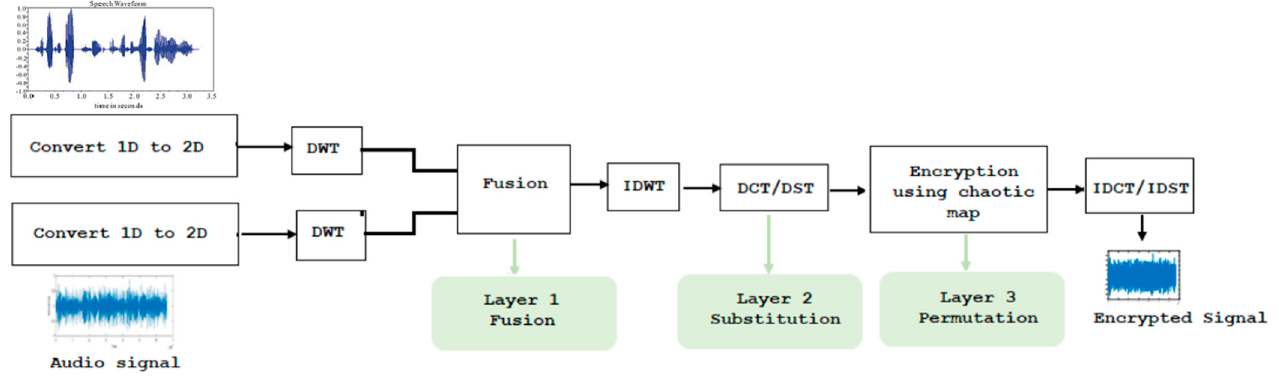
Figure 1. Cryptosystem based on three layers of encryption.